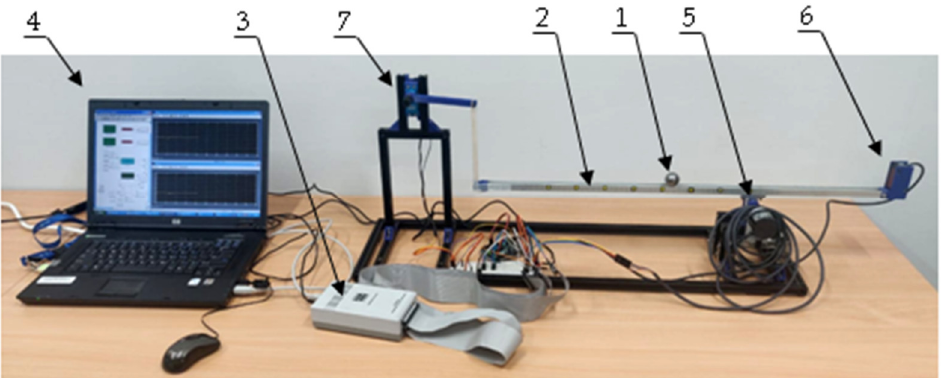
Figure 1. The ball and beam system used in the research.